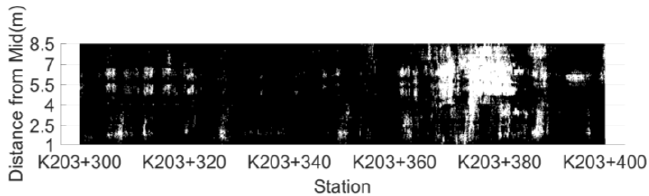
Figure 7. The distribution map of low compaction level segregation risk area.